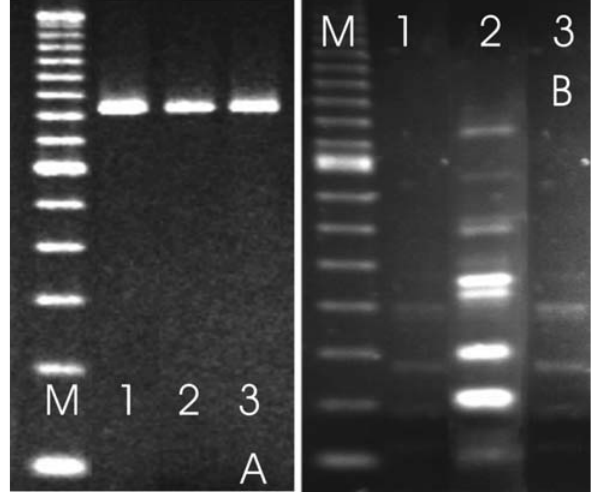
Figure 3 - Amplification products of two bacterial isolates from the same patient. A. rDNA-PCR of P. aeruginosa ATCC 9027 (lane 1), bacterial isolate 21 (lane 2) and bacterial isolate 23 (lane 3). B. tDNA-PCR of P. aeruginosa ATCC 9027 (lane 1), bacterial isolate 21 (lane 2) and bacterial isolate 23 (lane 3). The molecular marker 100 bp ladder is shown in lane M.